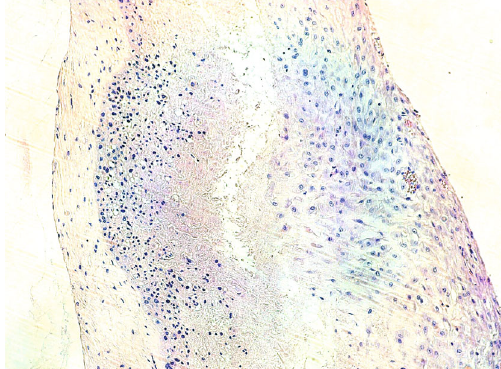
Figure 3: Membrane in fl ammatory in fi ltrate rich in lymphocytes (hematoxylin-eosin stain, original magni fi cation